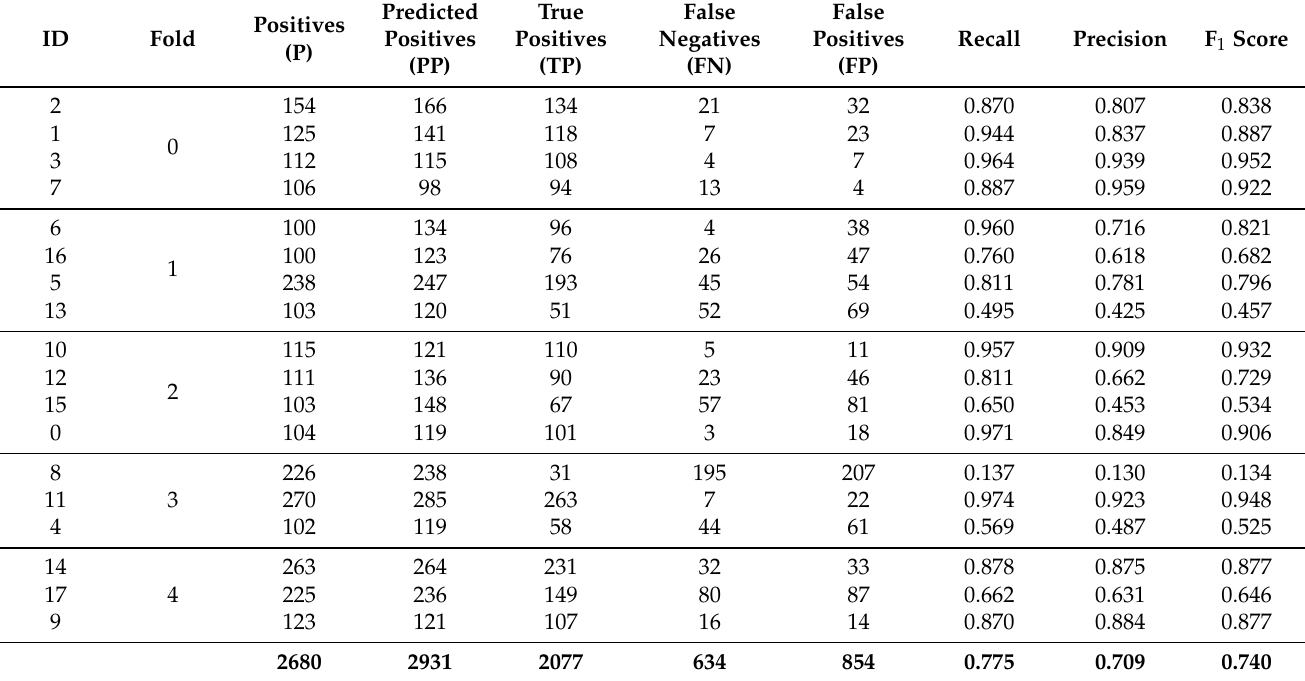
Table 3. 5-fold cross-validation results on the OTCD model. In each iteration, the metrics of the model’s predictions are evaluated for the captures with the indicated IDs , performing the training with the rest of the captures.